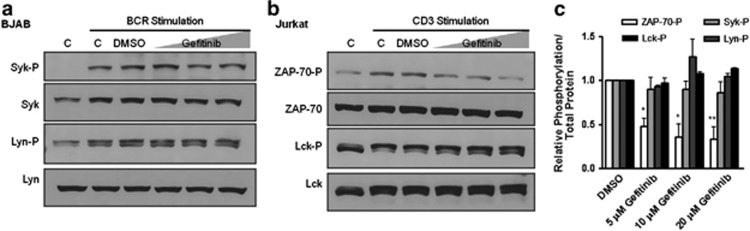
Gefitinib decreases ZAP-70 phosphorylation in Jurkat cells. (a) BJAB or (b) Jurkat cells treated with DMSO, and 5, 10, and 20 μM gefitinib, and stimulated with anti-IgM or anti-CD3, respectively. Untreated control cells (C) were left unstimulated (lane 1) or stimulated (lane 2). Lysates collected after 1 h and analyzed by western blot for Syk/ZAP-70 and Lyn/Lck phosphorylation. (c) Bands quantified using ImageJ of three independent experiments. Standard errors are shown. *P<0.05, **P<0.01